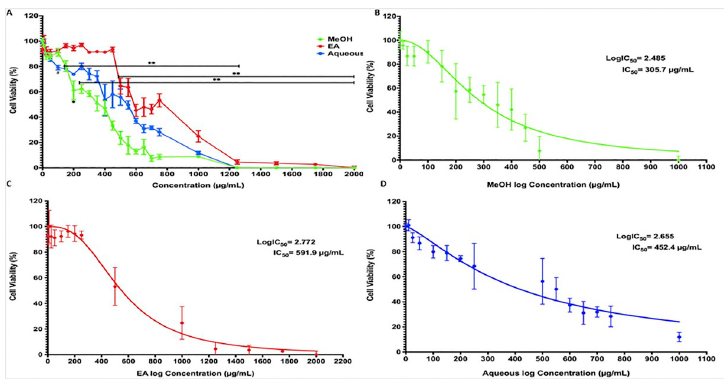
Fig 1. MTT assay showing the effect IC 50 value of B . spergulifolius extracts on 3T3-L1 cell viability. A. Effect of B . spergulifolius extracts on 3T3-L1 cell viability. The mature 3T3-L1 adipocytes were treated for 24 h with increased concentration of Methanol (MeOH), Ethylacetate (EA), and Aqueous extracts of B . spergulifolius . Also, cell treated without crude plant extract was taken as a control. B-D. The half-maximal (50%) inhibitory concentration (IC 50 ) value of the B . spergulifolius extracts. The IC 50 value is calculated by non-linear regression model. Data expressed as the means ± SD from three independent experiments. To analyse statistically was used one-way ANOVA test. � p = 0.033, # p = 0.001 and �� p < 0.001, significantly different from control.